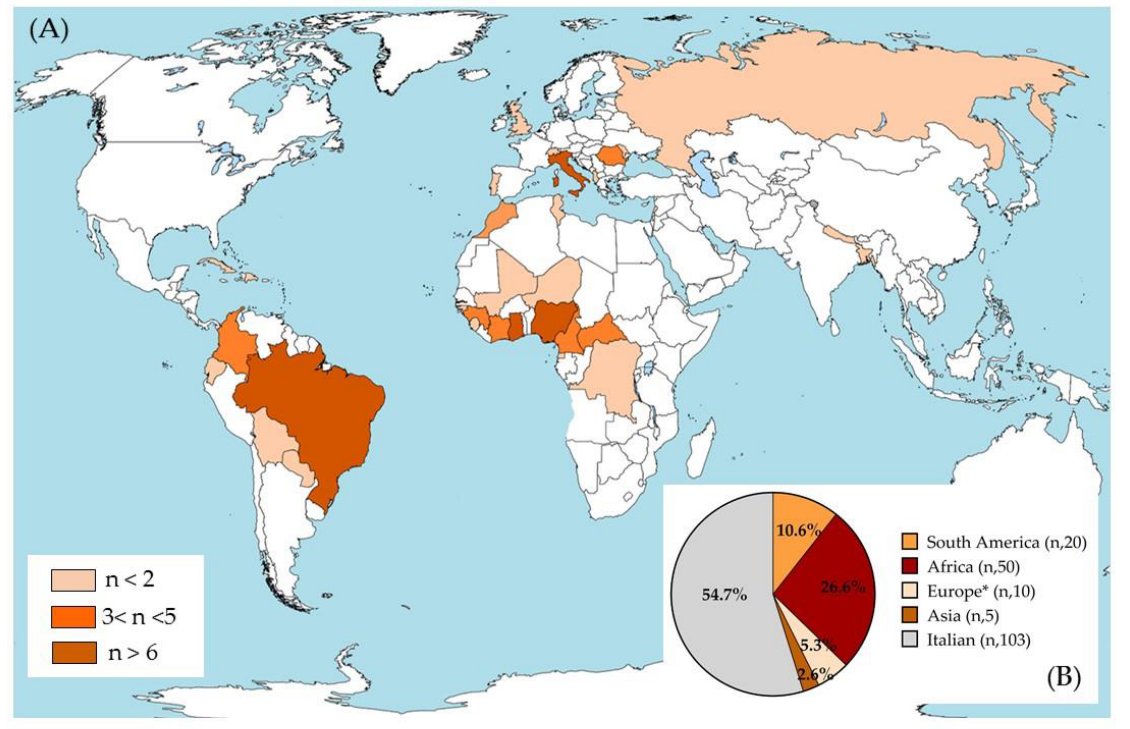
Figure 1. Geographical distribution of the population studied. ( A ) The three colors represent the total number of isolates for each country, as defined in the legend ( n = sample size). ( B ) The pie chart represents the sample size for each continent and the relative percentage of the population compared to all subjects included in the study. * Europe without Italy. This image was modified starting from the file BlankMap-World-v6.png from the Wikimedia Commons free media repository; GNU Free Documentation License.